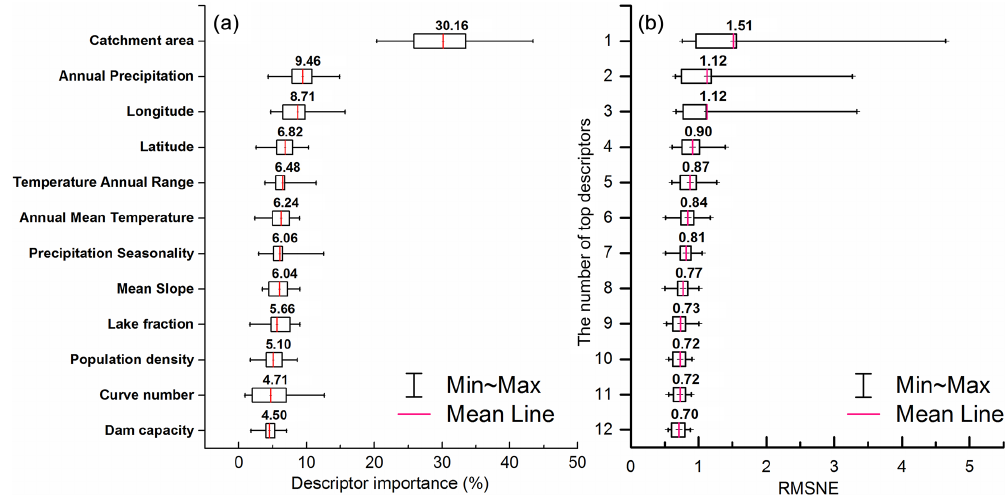
Figure 7. (a) Descriptor importance evaluated by the RF model and (b) the optimal number of catchment descriptors for SVM regression.